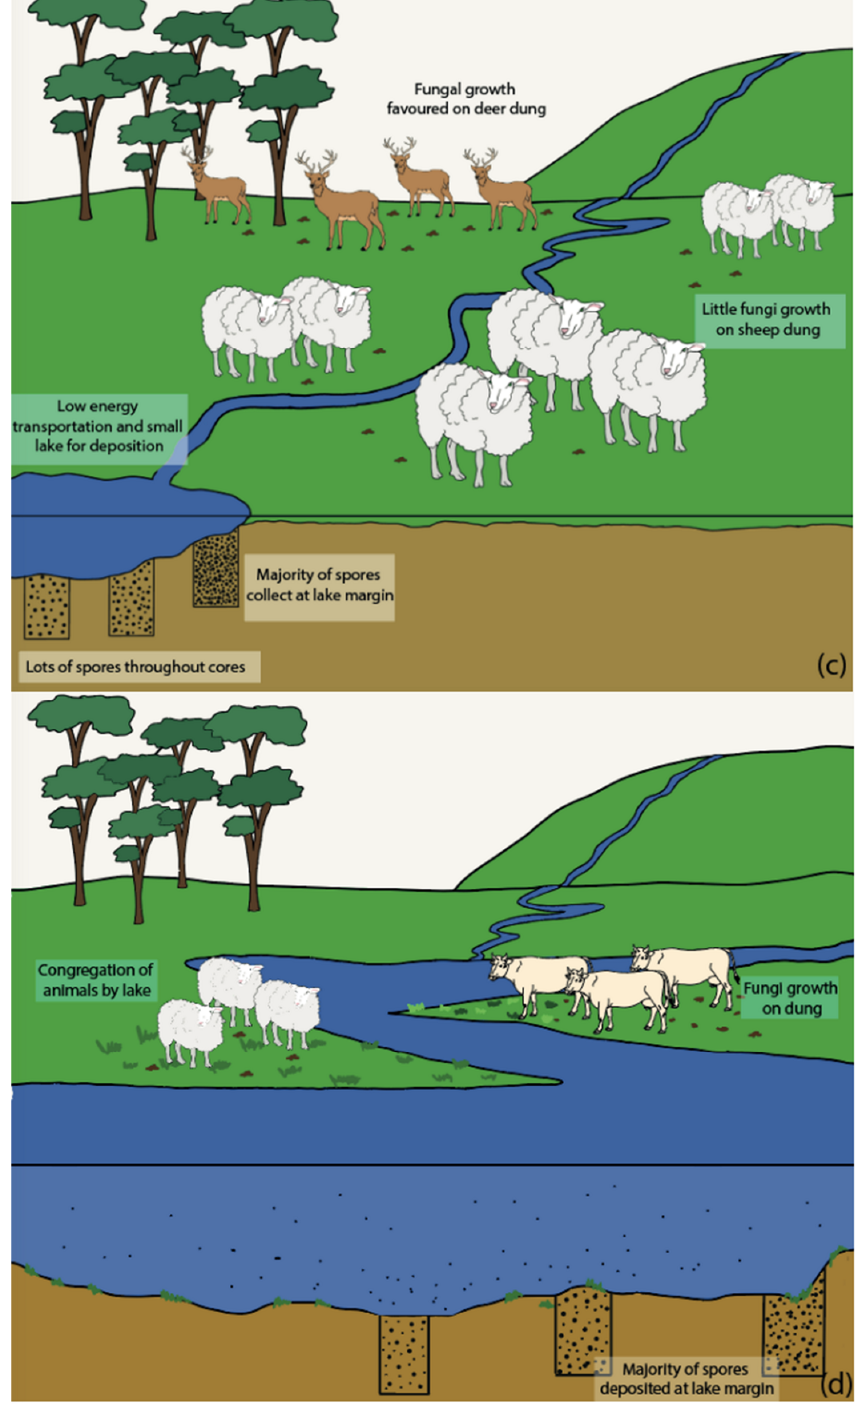
Figure 9. Schematic diagram of the possible external influences on spores at the time of dispersal and deposition. ( a ) Cows in a lacustrine environment with high energy river influx, resulting in the large deposition of spores in the middle of the lake, despite cow dung deposits being far away from lake. ( b ) Heavy rain and wind in a lacustrine environment with cows congregating and multiple river influx into the lake. ( c ) Low energy stream with small lake and multiple sheep and deer resulting in large amounts of spores throughout the lake. ( d ) Sheep and cows in a lacustrine environment with no rain, no wind, and one low energy river influx resulting in small amount of spore deposition that congregates on the edge of the lake.